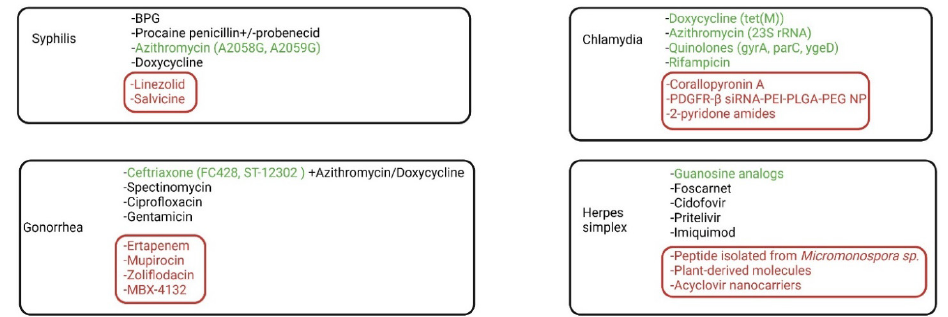
Figure 4. Current no demonstrated drug-resistance (black color), demonstrated drug-resistance (green color), and novel molecules (red color). Plant-derived drugs, nanoparticles, D-alanyl-D-alanine inhibitors, topoisomerase inhibitors, and novel antibiotics provide excellent options against worldwide emerging drug-resistant sexually transmitted germs.